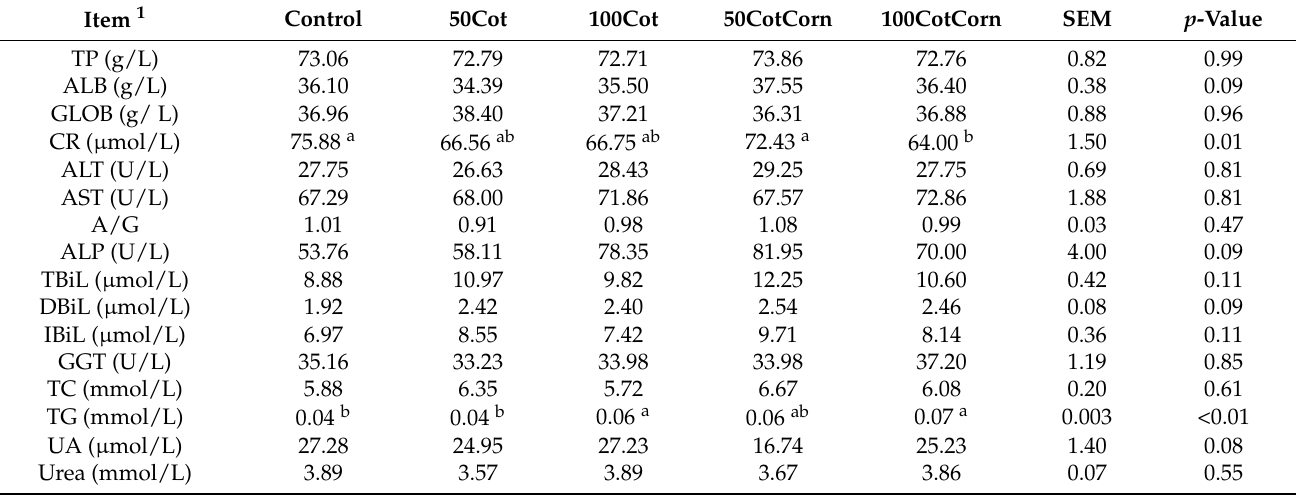
Table 5. Blood metabolites of dairy cows fed diets containing mildewy corn meal and